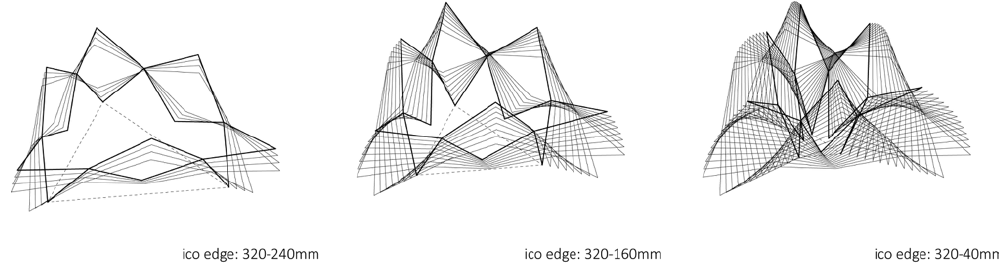
Figure 3. The design development of the adaptive component simulation of the scissor truss motion using a spring system